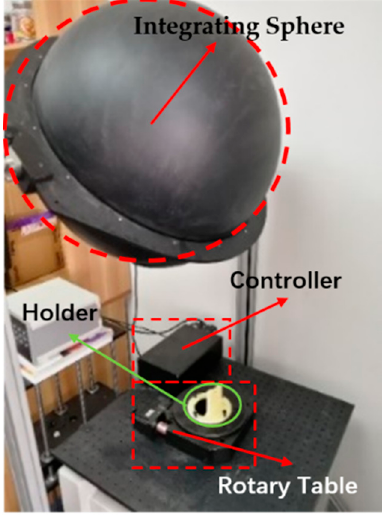
Figure 4. Indoor calibration experiment environment.